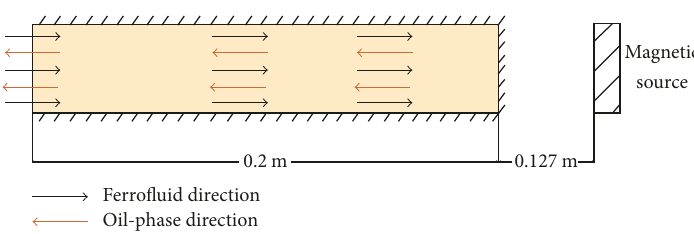
Figure 2: Magnet is placed on the right side of the core, with a core length, ℎ = 0.2 m, and magnet parameters, 𝑎 1 = 1.5 × 10 4 , 𝑏 1 = 2.4 × 10 −5 , 𝐵𝑟 = 1.19, 𝑎 = 𝑏 = 0.0254, 𝐿 = 0.127 m,and 𝜇 = 4𝜋10 −7 , and magnet positioned at 𝑥 = 0.2 m, 𝑦 = |𝑥 − 0.2| m. 0